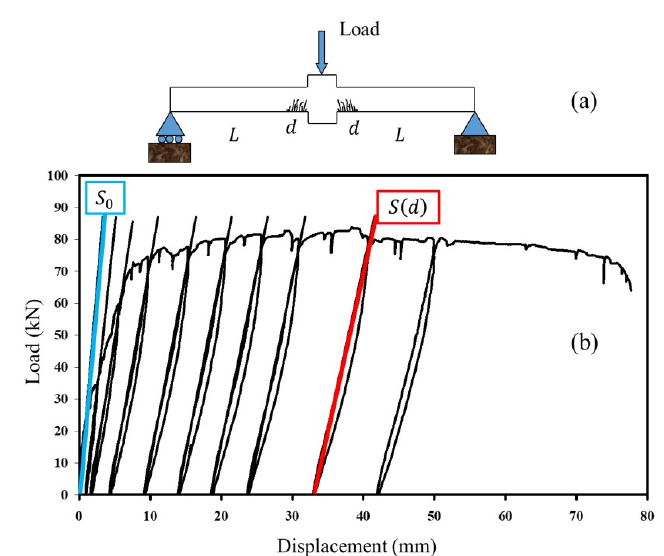
Figure 3. Graphical representation of damage measurement (adapted from